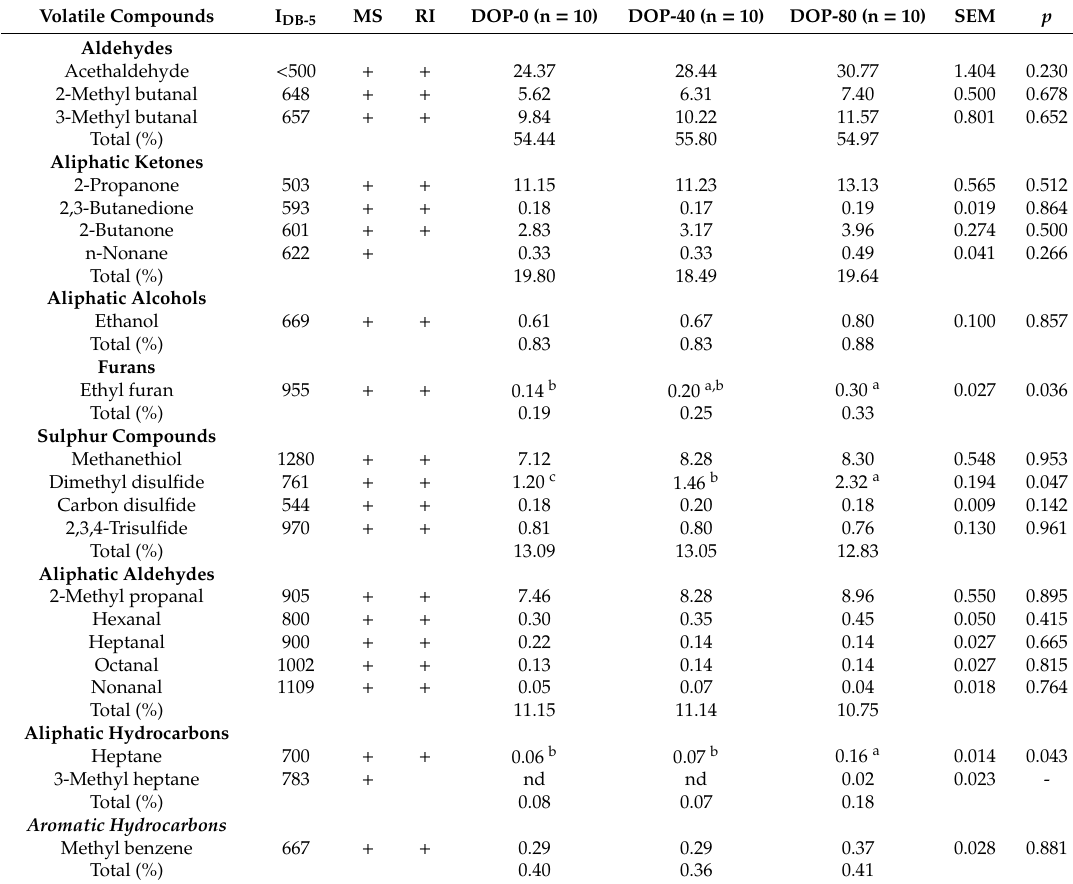
Table 5. Volatile compounds of the meat of suckling goat kids (expressed in area unit × 10 6 ) according to the use of dehydrated orange pulp in feeding dams 1